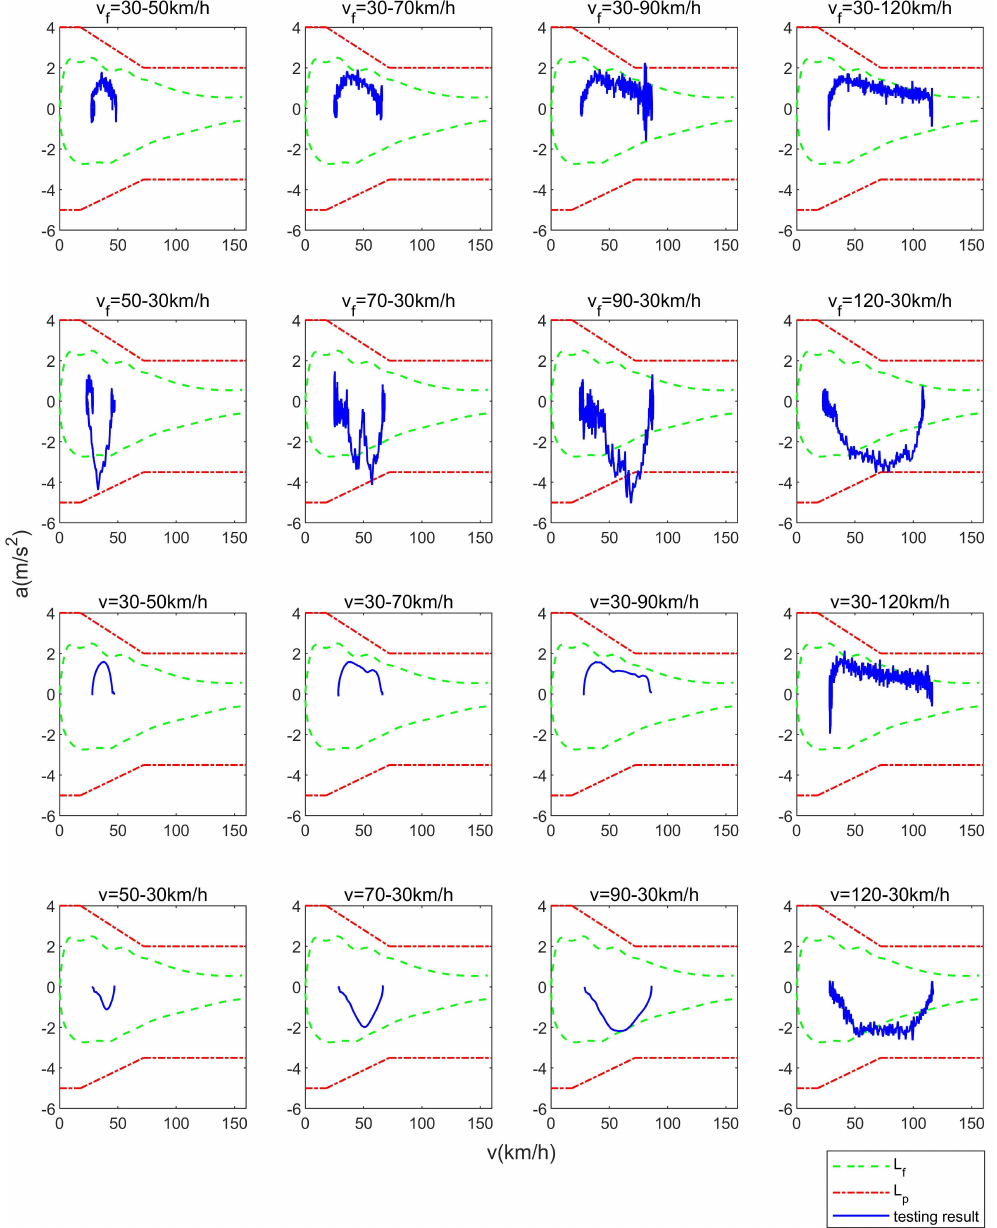
Figure 9. Human-like evaluation results under car-following scenarios with an accelerating leading